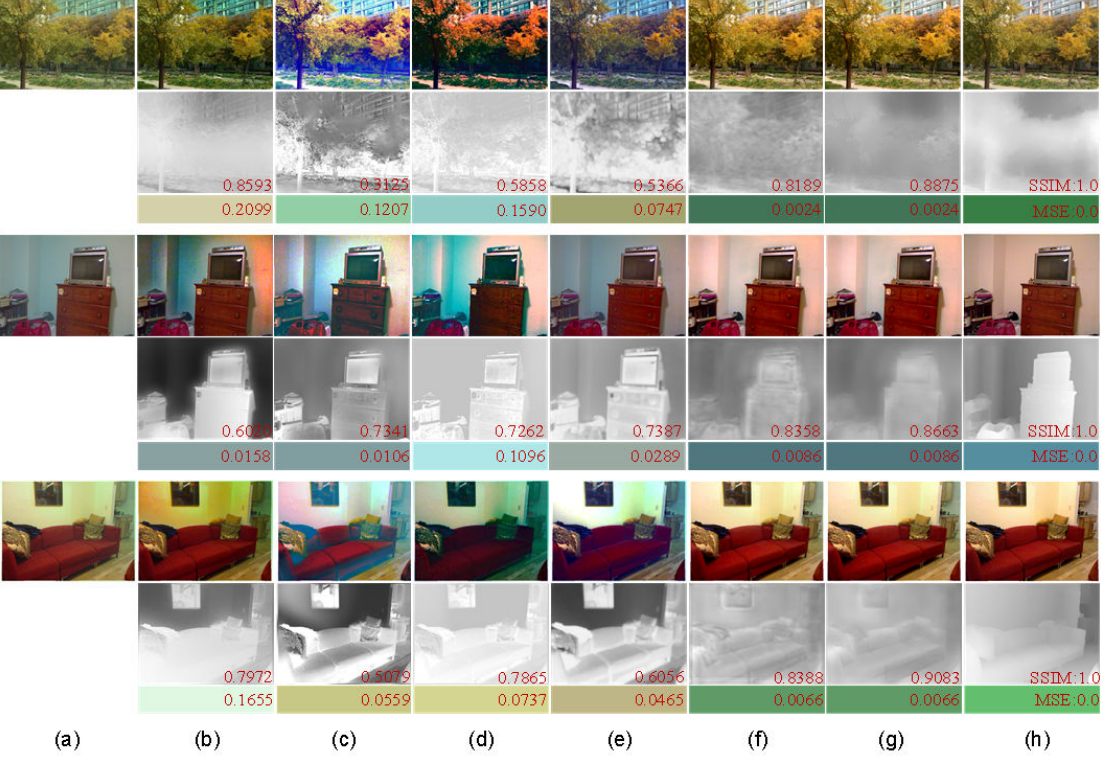
Figure 10. Comparisons of the restored images and their corresponding estimated blue-channel transmission and ambient light by different methods. Each ambient light is visualized as a colored bar for the convenience of comparison. ( a ) the input synthetic underwater images; ( b ) the results of Drews et al. [20]; ( c ) the results of Li et al. [24]; ( d ) the results of Berman et al. [25]; ( e ) the results of Shin et al. [29]; ( f ) our results without the guided filter; ( g ) our results with the guided filter; ( h ) the ground truth clear